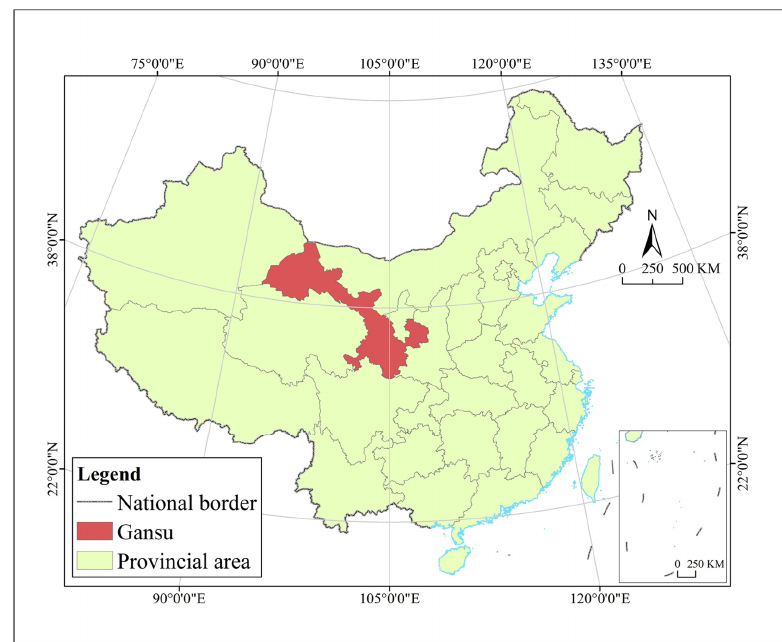
Figure 1. Location of the Study Area.